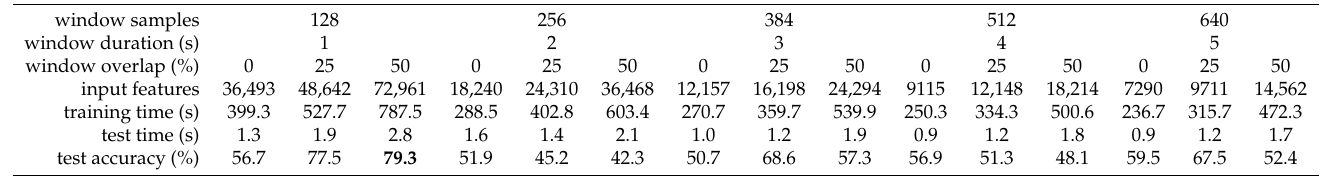
Table 4. Experimental results for original temporal data, best result is displayed in bold. window samples